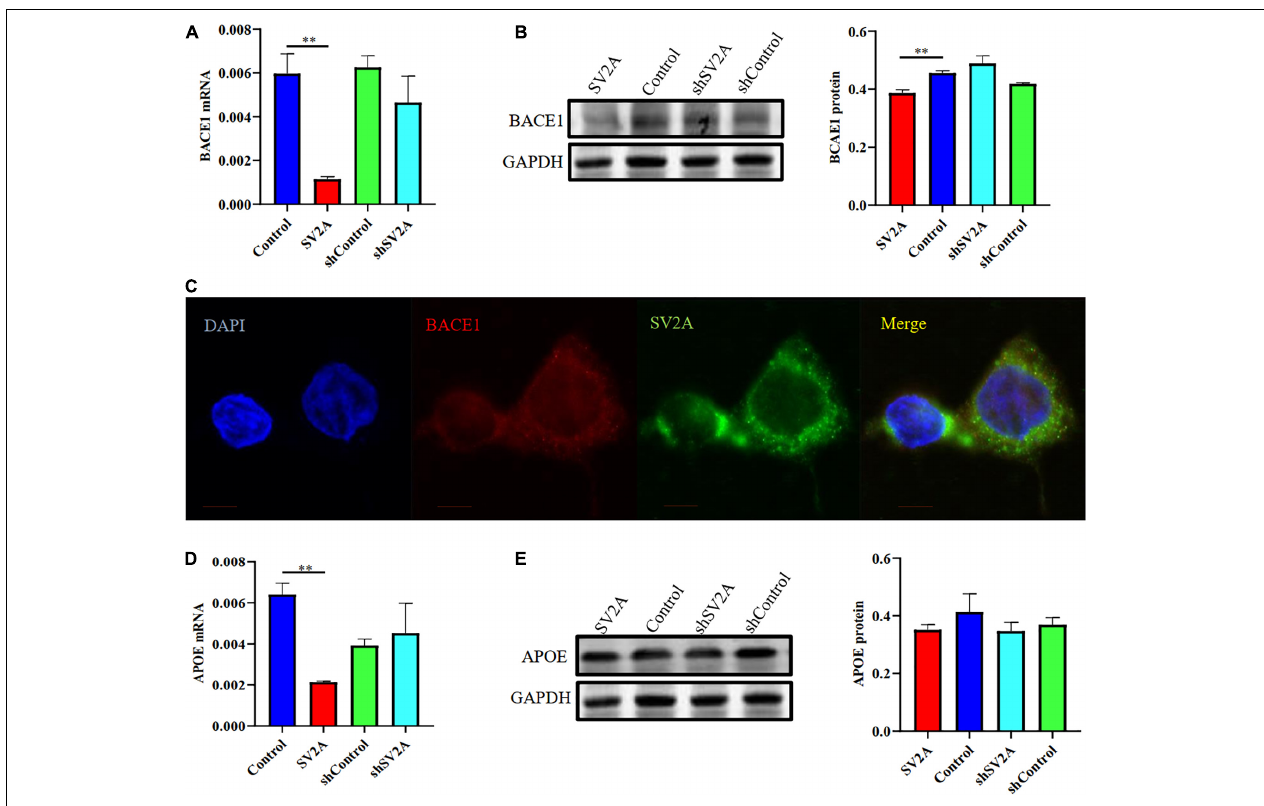
FIGURE 3 | SV2A regulates the expression level of BACE1 and APOE. (A) qPCR detection of BACE1 mRNA expression level in APPswe293T cells from the following four groups: control, cells infected with the SV2A-overexpressing virus (SV2A), shControl, and cells infected with the SV2A-silencing virus (shSV2A). Gapdh was used as the internal control. (B) Western blotting detection of BACE1 expression levels in APPswe293T cells from the following four groups: control, cells infected with the SV2A-overexpressing virus (SV2A), shControl, and cells infected with the SV2A-silencing virus (shSV2A). The gray density was normalized to the mean gray density of Gapdh. (C) Immunofluorescence observation of the BACE1 (red) and SV2A (green) in APPswe293T cells. The nuclei were counterstained with DAPI (blue). Scale bar, 40 µ m. (D) qPCR detection of the APOE mRNA expression level in APPswe293T cells from the following four groups: control, cells infected with the SV2A-overexpressing virus (SV2A), shControl, and cells infected with the SV2A-silencing virus (shSV2A). Gapdh was used as the internal control. (E) Western blotting detection of APOE expression levels in APPswe293T cells from the following four groups: control, cells infected with the SV2A-overexpressing virus (SV2A), shControl, and cells infected with the SV2A-silencing virus (shSV2A). The gray density was normalized to the mean gray density of Gapdh. For each group of APPswe293T cells, n = 3. Data are expressed as mean ± SEM. One-way analysis of variance (ANOVA). ** p <